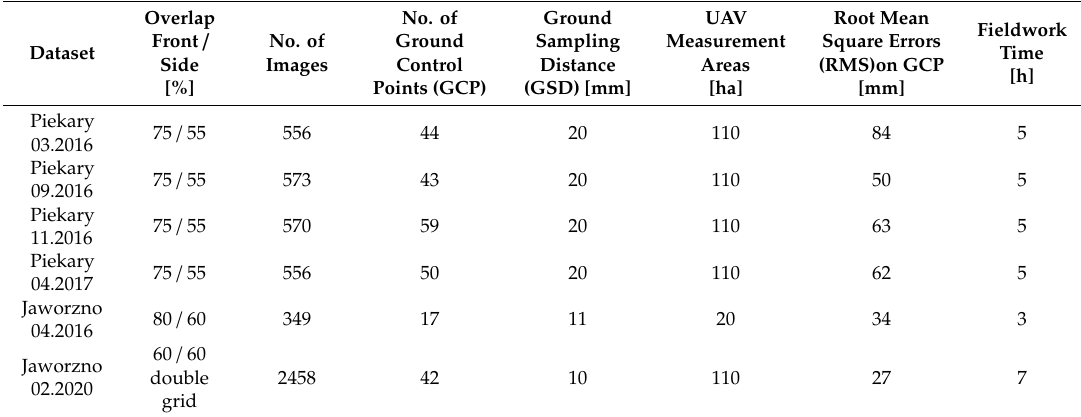
Table 1. Summary of the unmanned aerial vehicles (UAV) photogrammetric